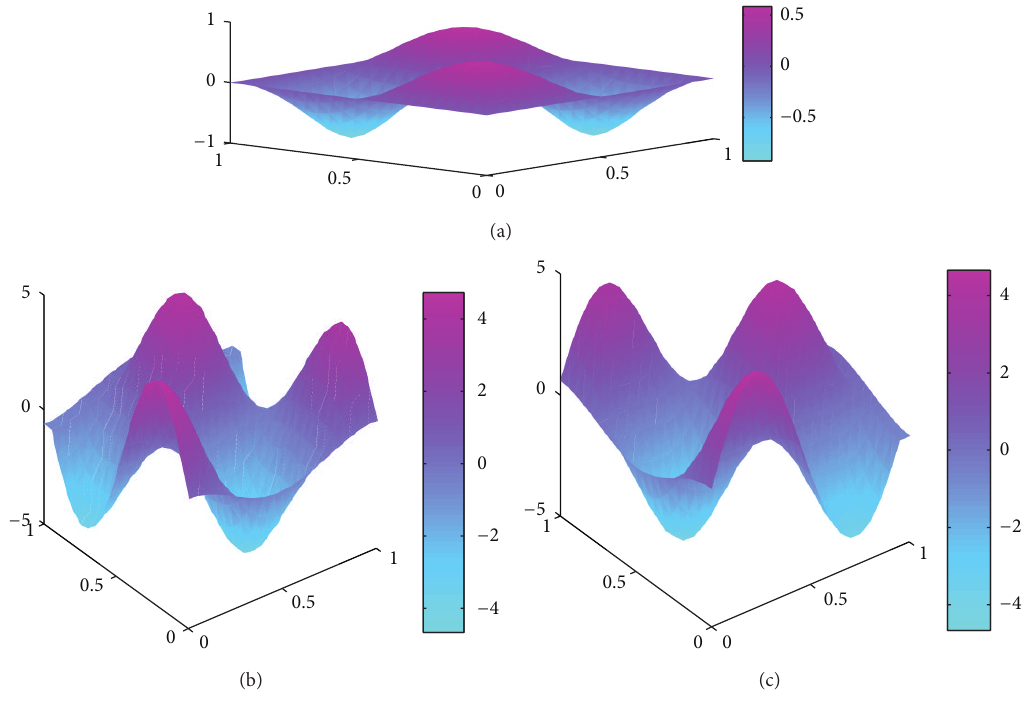
Figure 3: The figures of 𝑢 ℎ and p ℎ ((a) for 𝑢 ℎ , and (b), (c) for p ℎ ).